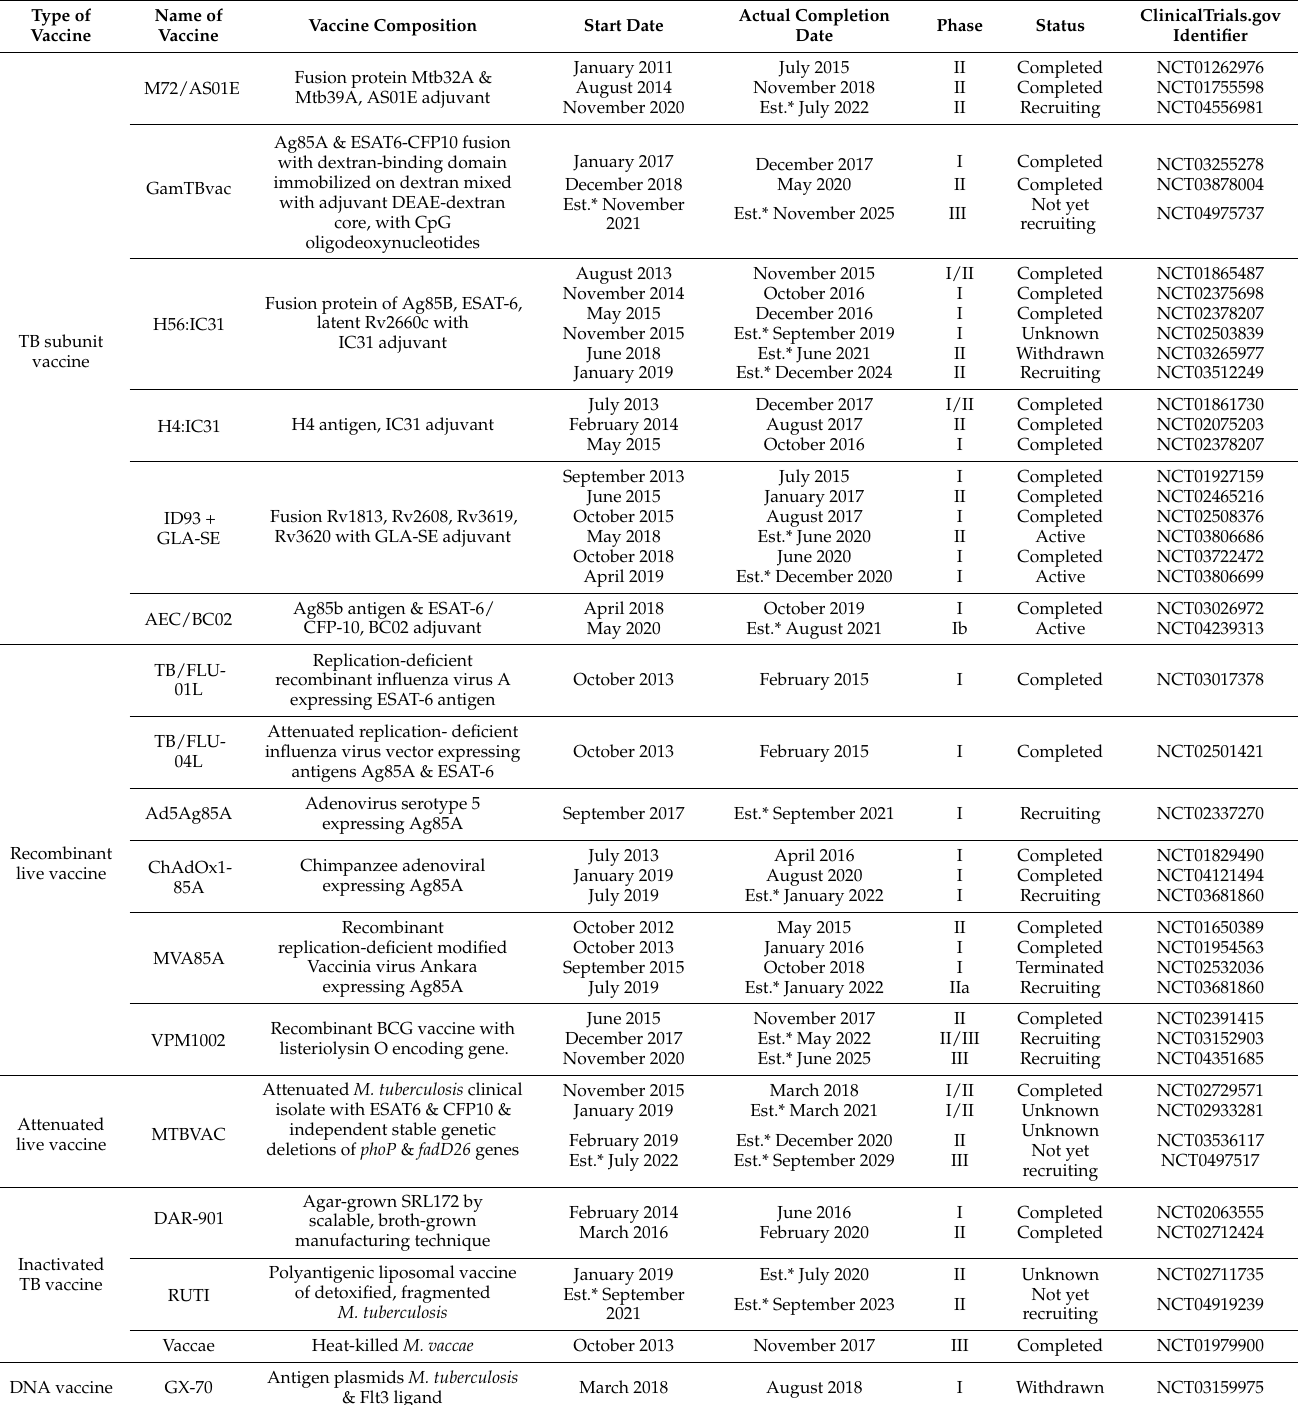
Table 1. Vaccine candidate trials started/completed in